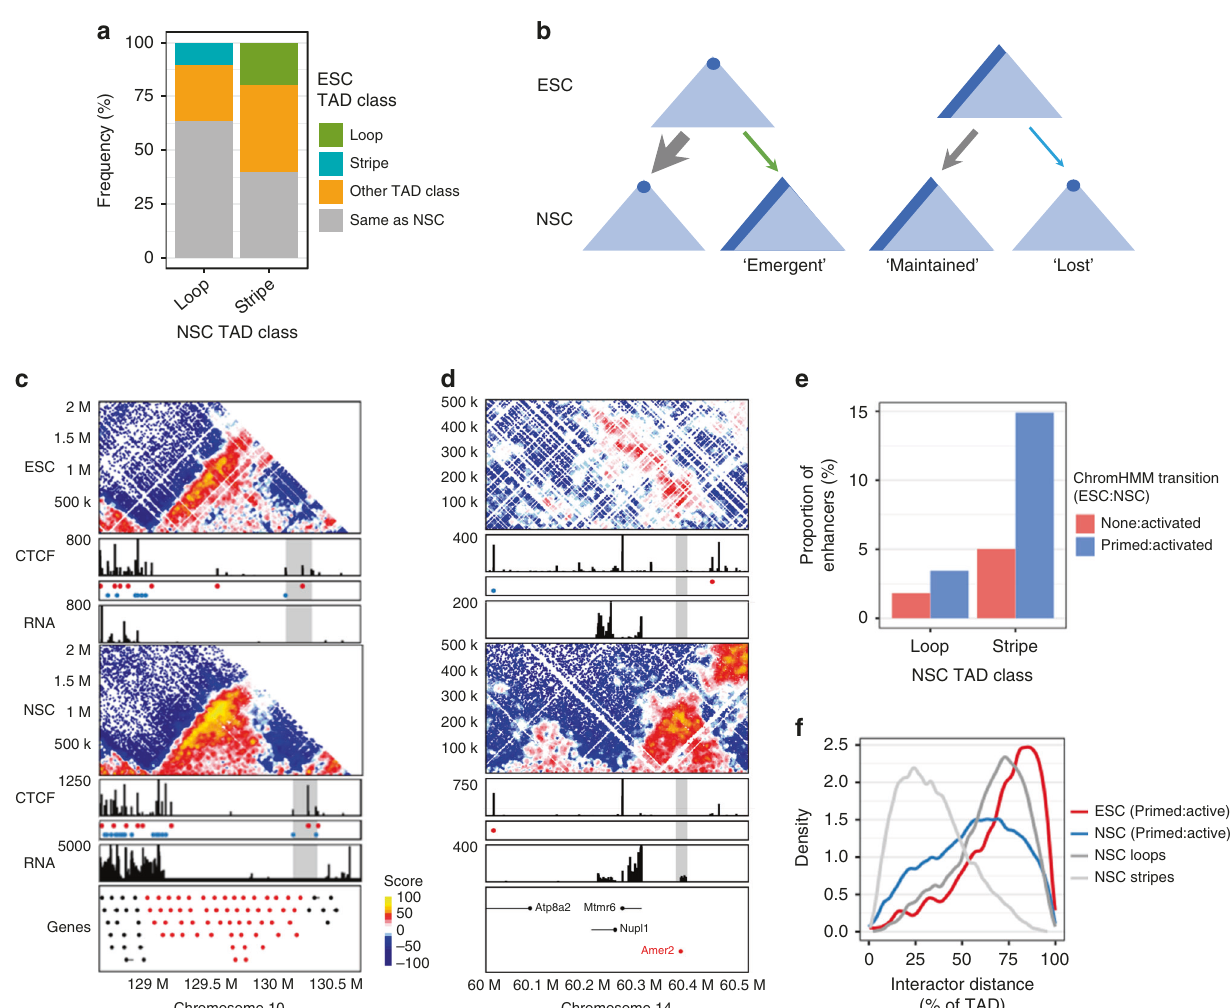
Fig. 5 Structural changes to stripe TADs accompanying differentiation are coincident with changes in CTCF occupancy or lineage-appropriate enhancers. a TAD class dynamics between ESC and NSCs. ESC TADs separated into loop or stripe domains that maintain at least one border during differentiation, and their classi fi cation in NSCs. Frequency represents the proportion of NSC classi fi ed domains that were maintained or changed from a given ESC TAD group. b Schematic representation of data in ( a ) revealing the fates of TAD classes during differentiation. c , d Hi-C contact maps from ESCs and NSCs revealing TAD class changes associated with CTCF-binding site occupancy or transcription changes. CTCF ChIP-seq tracks, motifs, gene annotations, and gene expression are shown as before. c A 2.1 Mb region on chr10 around the Olf gene cluster changes from an ESC stripe to an NSC loop domain in conjunction with an increase in CTCF signal in NSCs at the unanchored stripe border (highlighted grey). d New insulation at a 500 kb region on chr14 is associated with a change from an ESC stripe to an NSC loop domain upon NSC-speci fi c expression of Amer2 . e Activated NSC enhancers de fi ned by ChromHMM which were either unclassi fi ed ( ‘ None ’ , red) or Primed (blue) in ESCs and their distribution in NSC loop or stripe domains. f Distribution of intra-TAD contact distance as a proportion of TAD size, in ESC (red) or NSC (blue) Hi-C maps from active NSC-speci fi c enhancers which were primed in ESCs (Primed:active). As a comparison, the distribution of contact distances in loop (dark grey) or stripe (light grey) NSC domains are also shown. Note the shift between the blue and red distributions upon activation of NSC enhancers. Enhancer elements were expanded by 20 kb to include enough